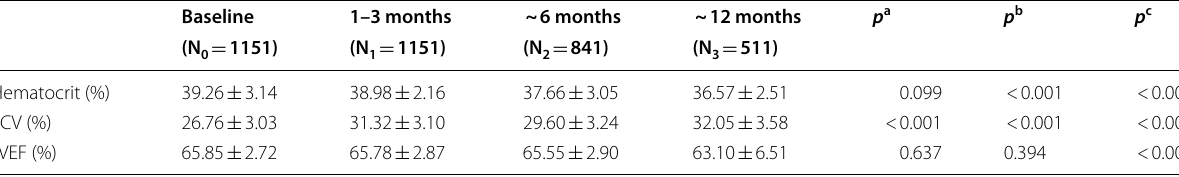
Table 2 Hematocrit, extracellular volume (ECV) and left ventricular ejection fraction (LVEF) values at different time points